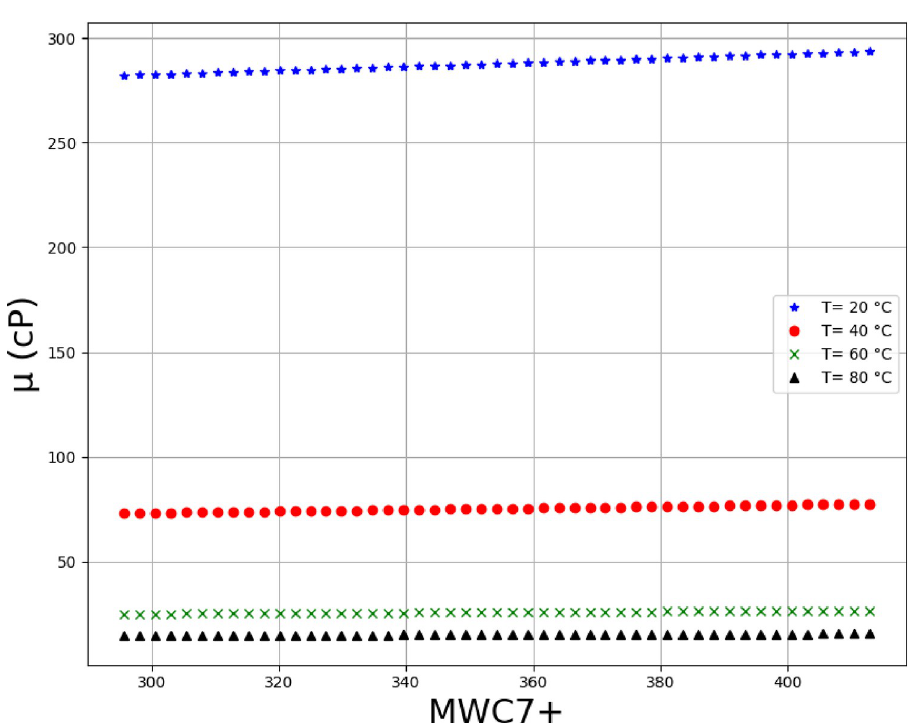
Fig 12. Trends of MWC7+on multiple temperature levels (API = 18.6, %C4 = 0.35, %C5 = 1.62, %C6 = 3.21, %C7+ = 94.81, SGC7+ = 0.95, ρ (g/cc) at 20˚C = 0.941). https://doi.org/10.1371/journal.pone.0282084.g012 PLOS ONE | https://doi.org/10.1371/journal.pone.0282084 February 17,